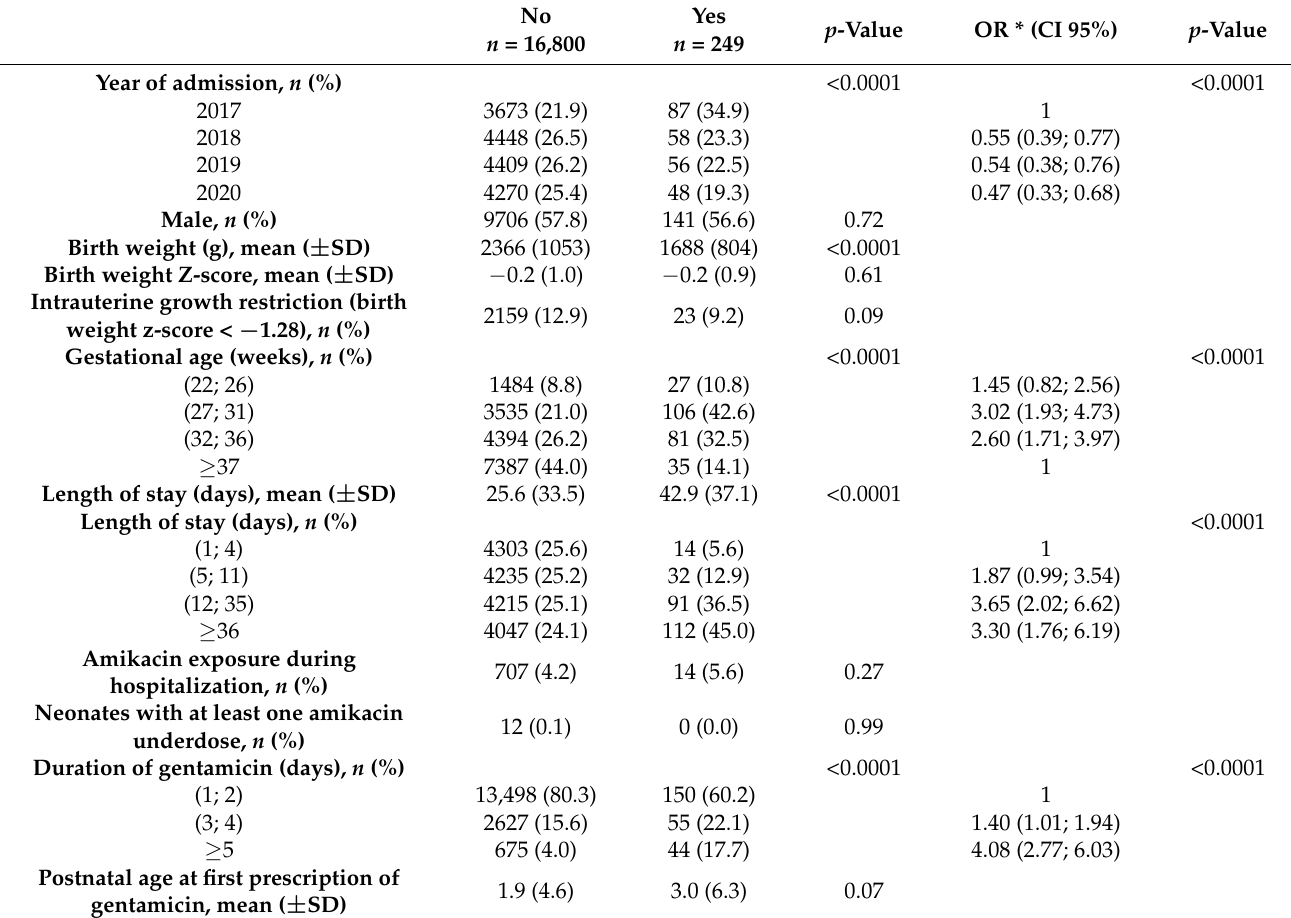
Table 5. Univariate and multivariate analysis of patients’ characteristics according to gentamicin